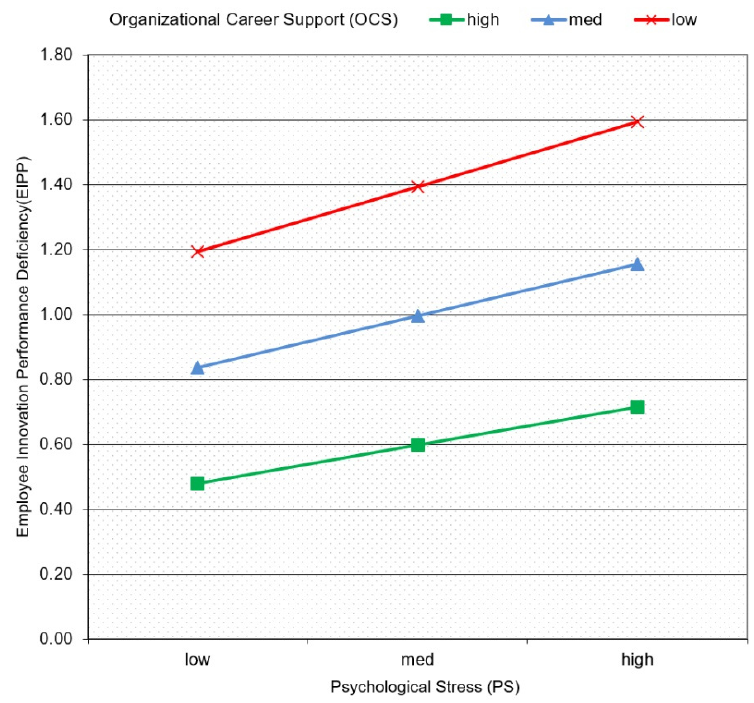
Figure 2. The moderating effects of OCS on PS and EIPD.